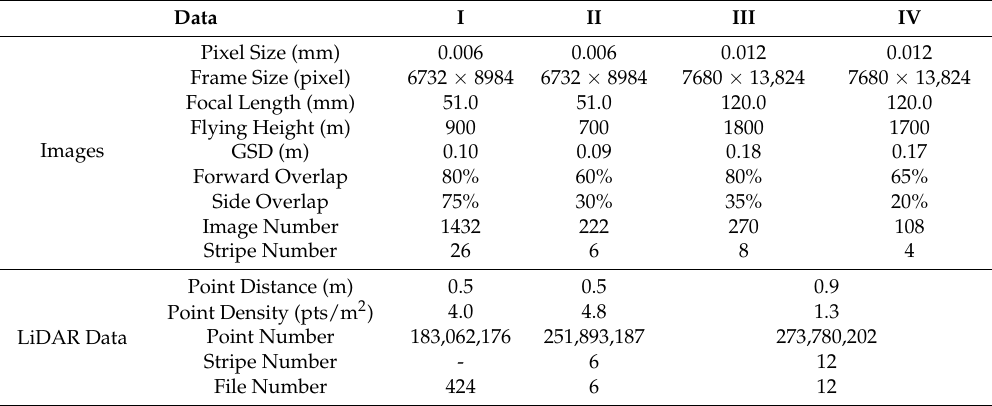
Table 1. Information on the aerial optical images and airborne LiDAR data 1